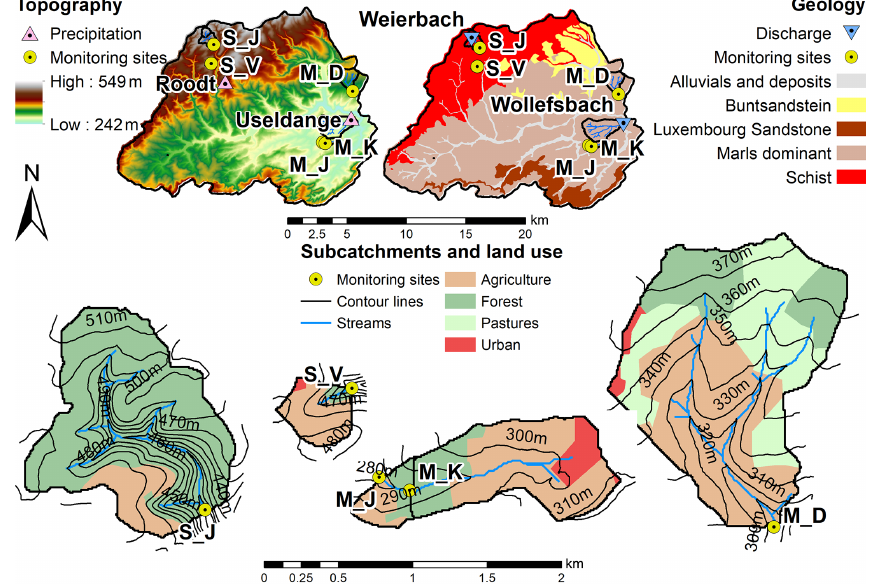
Figure 1. The Attert catchment in western Luxembourg and the five monitoring sites: M_D, M_J, M_K (marls), S_J and S_V (schist). Top left is catchment topography, top right is geology and the lower half shows the five subcatchments including land